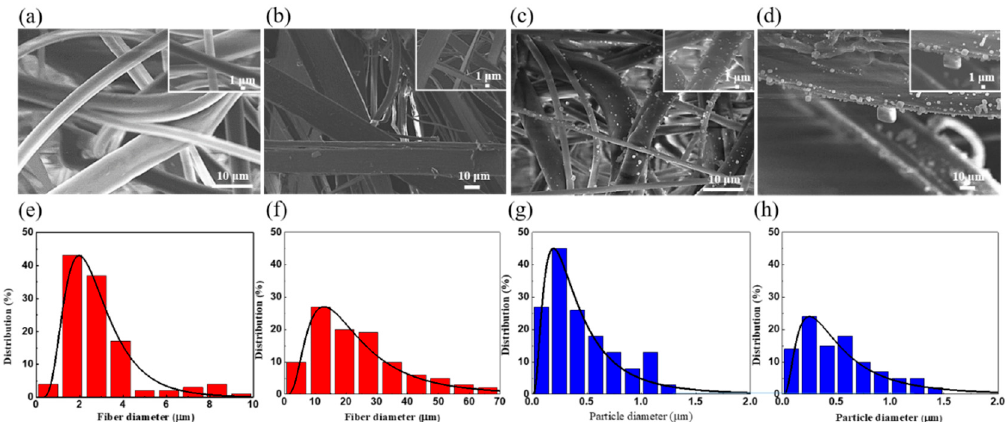
Figure 1. SEM images of ( a ) N95 mask and ( b ) 3M filter before capturing NaCl; those of ( c ) N95 mask and ( d ) 3M filter after capturing NaCl aerosols. Fiber distribution in ( e ) N95 mask and ( f ) 3M filter. The distribution of NaCl aerosols in ( g ) N95 mask and ( h ) 3M filter.